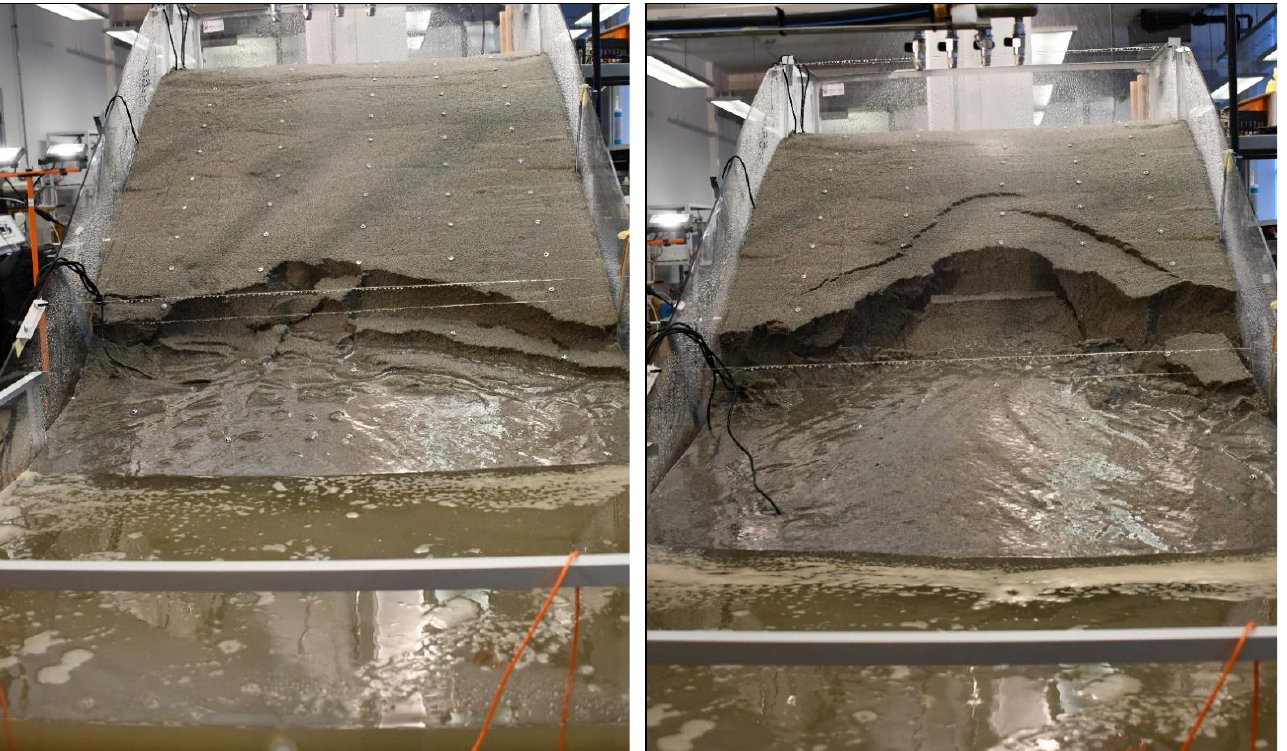
Figure 4. A photo of the Sand experiment around 90 min after the start of the rainfall simulation ( left ), showing the evolution of the retrogressive sliding following the formation of the rotational slide in the slope’s toe, and a photo taken at the start of the surface runoff formation in the upper part of the model at around 125 min after the beginning of the Sand experiment ( right